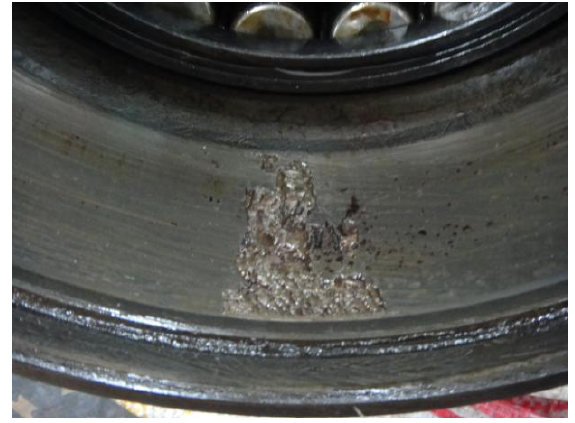
Figure 17. The spall fault on the outer race.